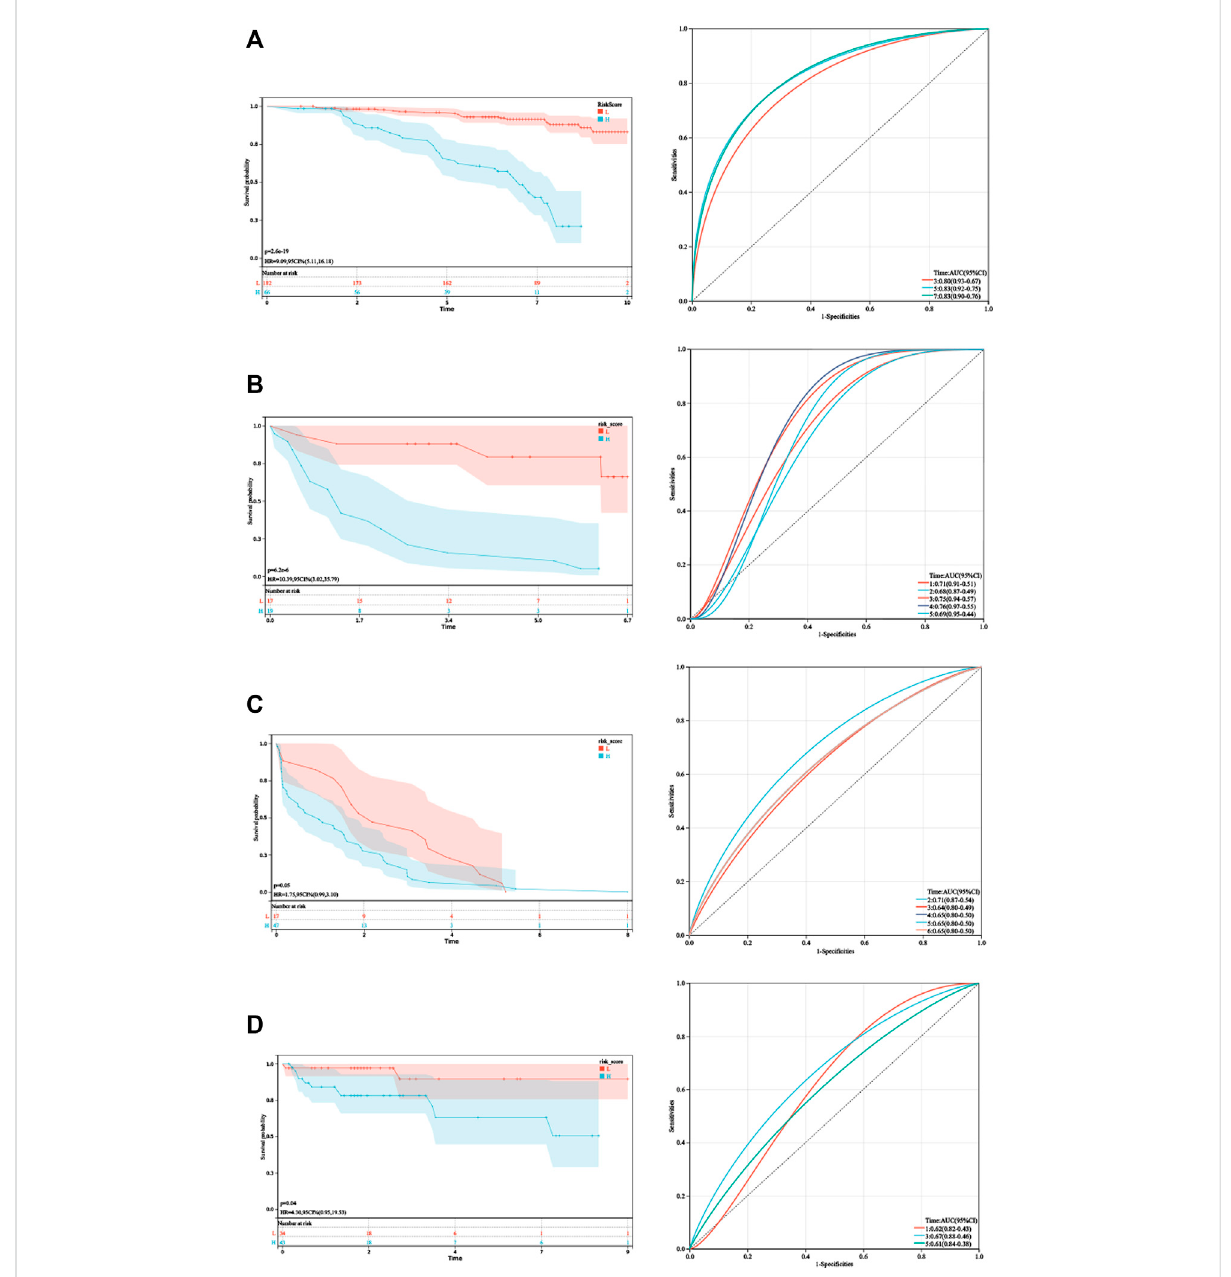
FIGURE 4 Validation of HPRS. (A) Kaplan – Meier analysis and ROC analysis of the hypoxia-related score based on GSE116918. (B) Kaplan – Meier analysis and ROC analysis of the hypoxia-related score based on GSE46602. (C) Kaplan – Meier analysis and ROC analysis of the hypoxia-related score based on GSE70770. (D) Kaplan – Meier analysis and ROC analysis of the hypoxia-related score based on